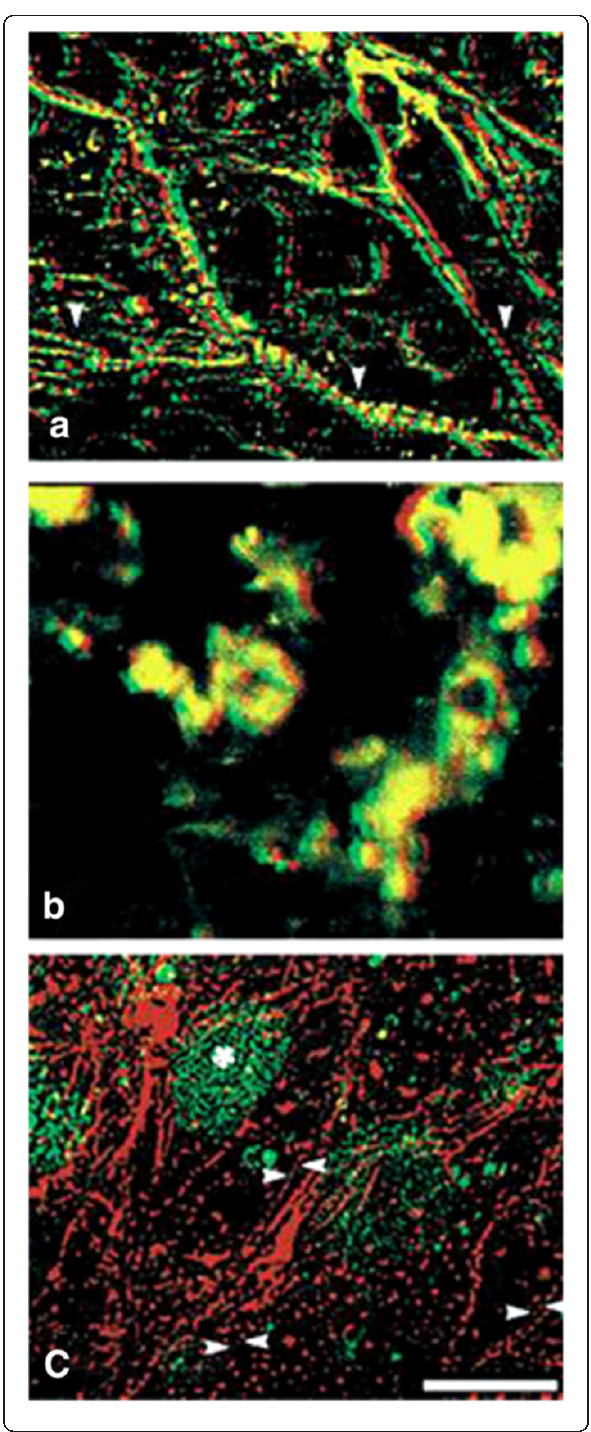
Figure 5 Effect of transfection of TM isoform-specific sense- and anti-sense oligonucleotides on myofibril organization in hearts from normal axolotl hearts. a. Stereo anaglyph of a 24 section confocal laser scanning microscope z-series of normal axolotl heart stained with CH1 anti-tropomyosin antibody. This type of image is shown because it demonstrates branching myofibrils in whole hearts. b. Stereo anaglyph of normal hearts transfected with TPM4 α